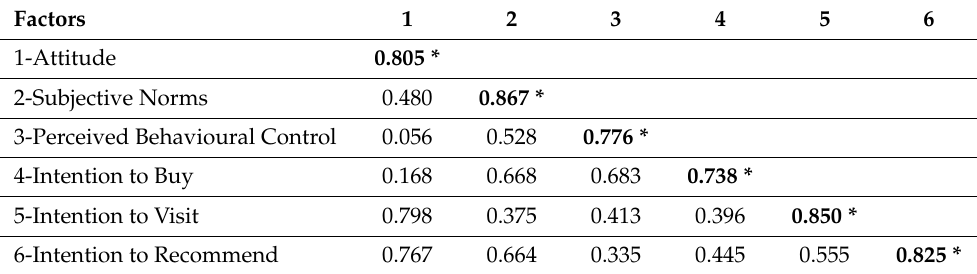
Table 4. The discriminant validity results.